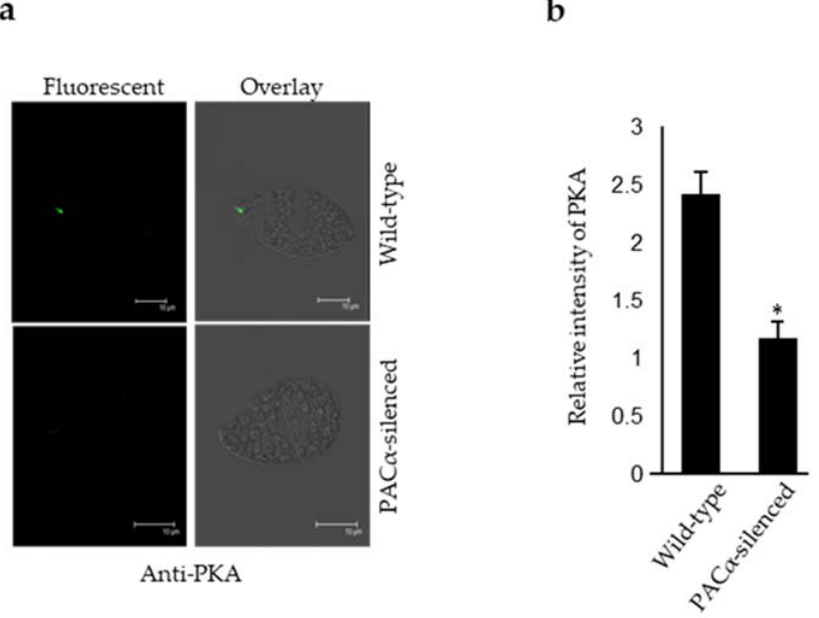
Figure 3. PKA content in PAC α -silenced cells. ( a ) Fluorescent and overlay images of wild-type and PAC α -silenced cells as determined by the IIFA using the Anti-PKA antibody. ( b ) Relative fluorescent intensity of PKA in wild-type and PAC α -silenced cells. Error bars indicate standard error mean. n = 50 cells; * indicates a Student’s t -test p -value < 0.01.